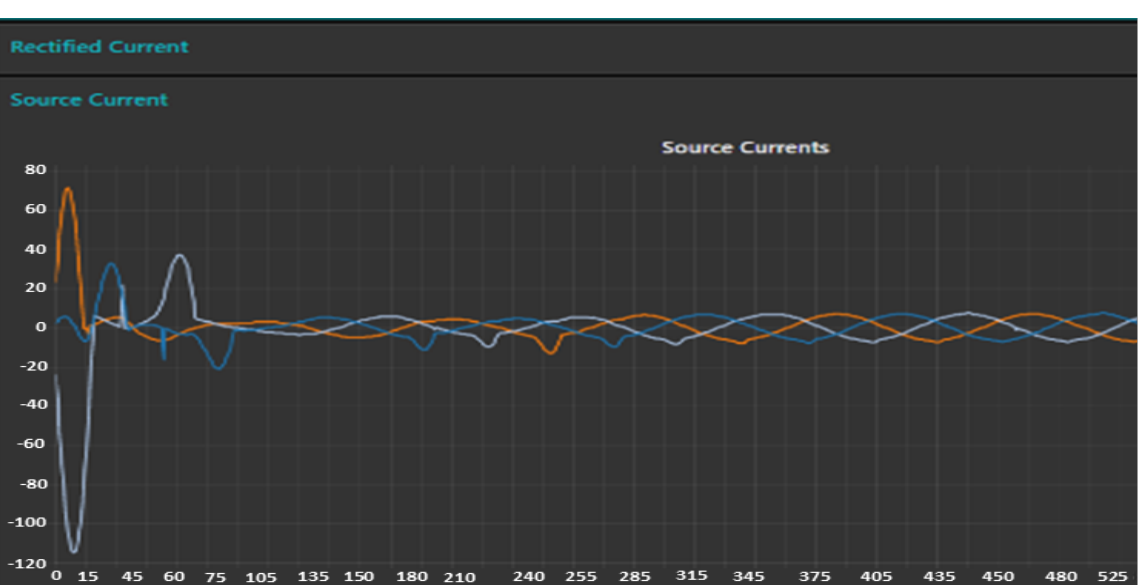
Figure 36. Historian Trends for Detailed Analysis.